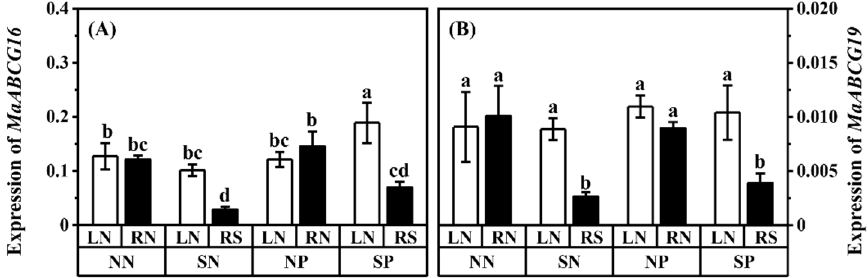
Figure 6. Expressions of MaABCG16 ( A )and MaABCG19 ( B ) in roots of M. alba . F and p -value of ANOVA were listed in Supplementary Table S3. Different letters above the columns in each graph indicated a significant difference among the means by Tukey’s test ( p < 0.05 ). The abbreviation is indicated a significant difference among the means by Tukey’s test ( p < 0.05). The abbreviation is consistent with Figure 1. consistent with Figure 1.